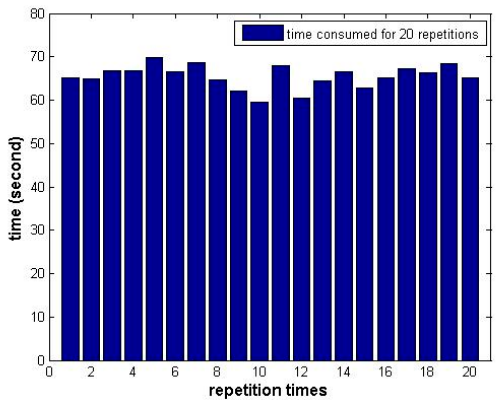
Figure 14. The time consumed for different iteration times of the modified ACO.